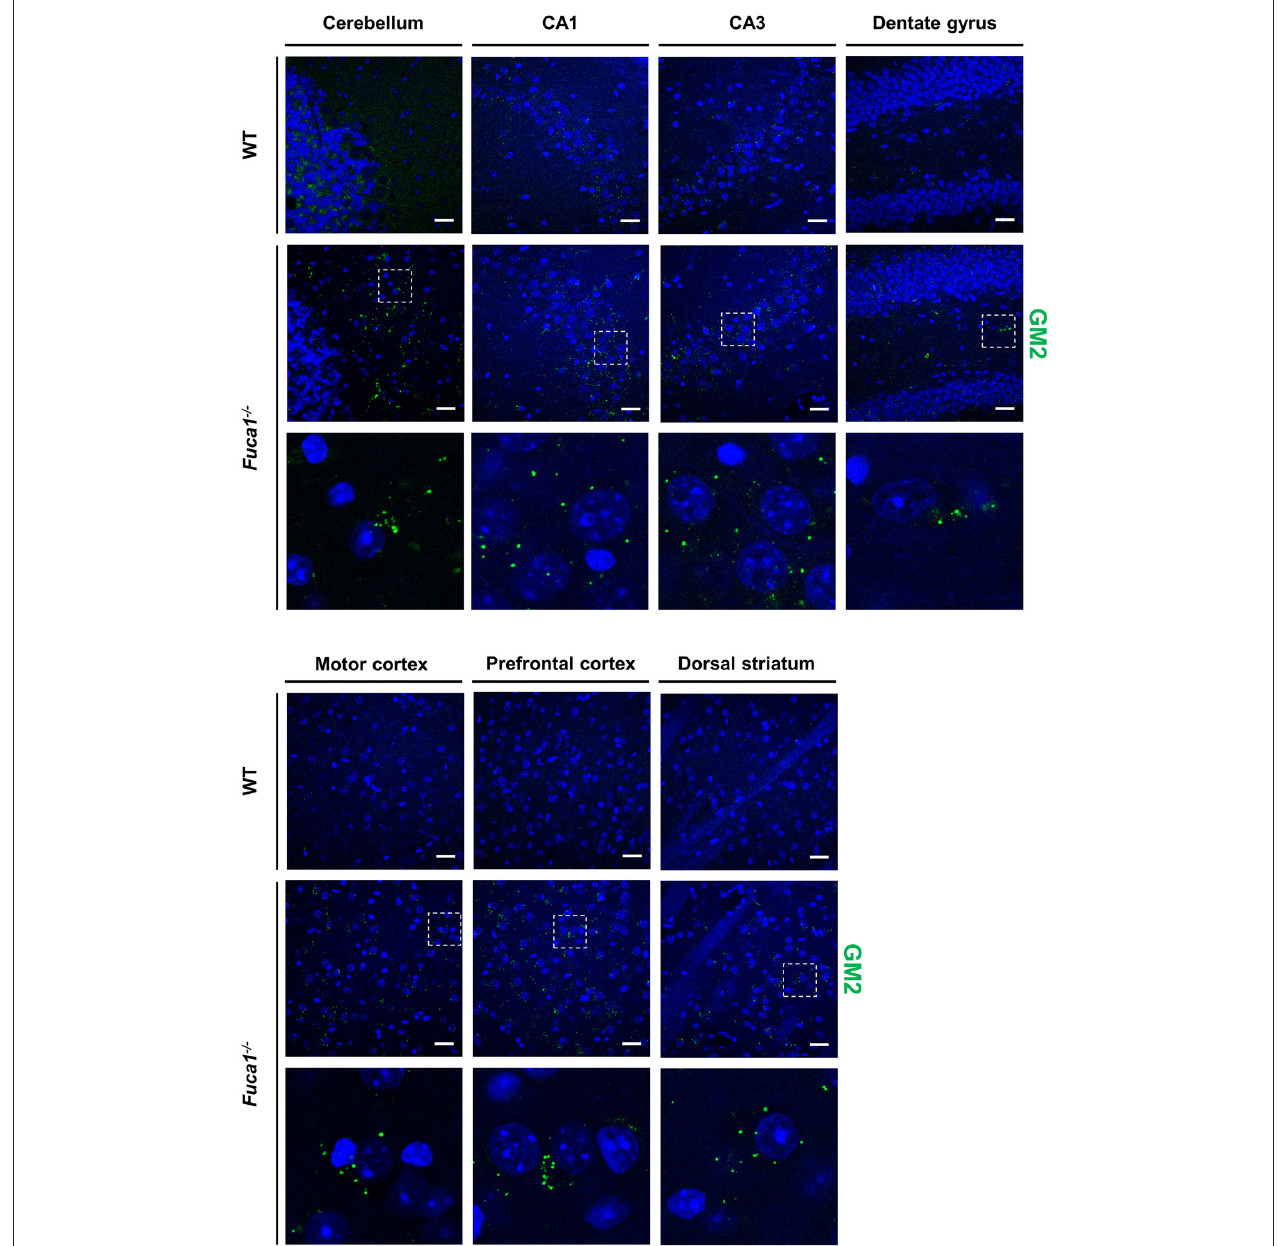
FIGURE 5 | Fuca1-deficient mice exhibit accumulation of GM2 ganglioside throughout the brain. Representative immunofluorescence staining of brain sections from 3-month-old mice showed signs of GM2 ganglioside accumulation in all analyzed regions (cerebellum, hippocampus, cerebral cortex, striatum) of the Fuca1-deficient brain. Magnified images of boxed areas illustrate prominent secondary lipid storage. Scale bars = 200 µ m. Nuclei were stained with DAPI.